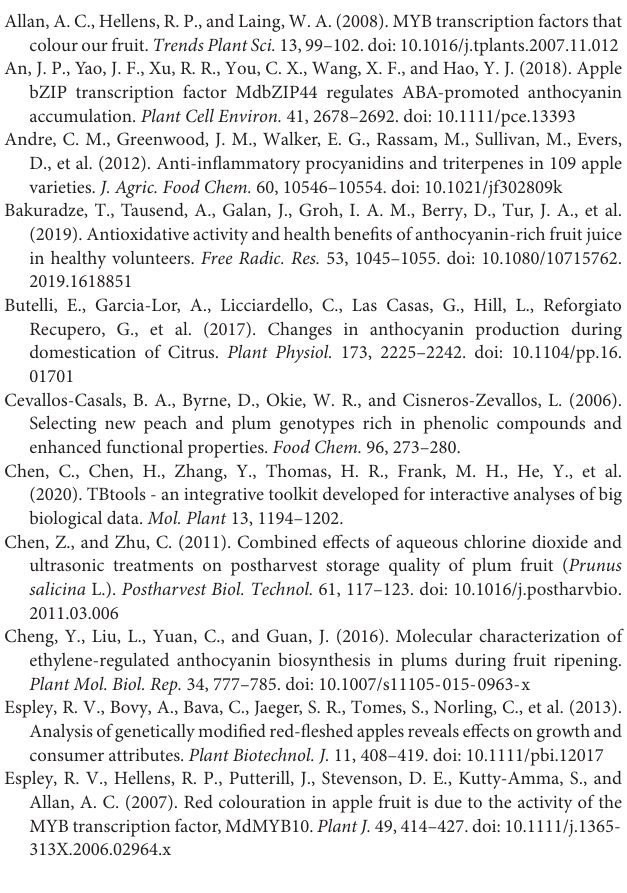
Supplementary Table 6 | Differentially expressed transcription factor